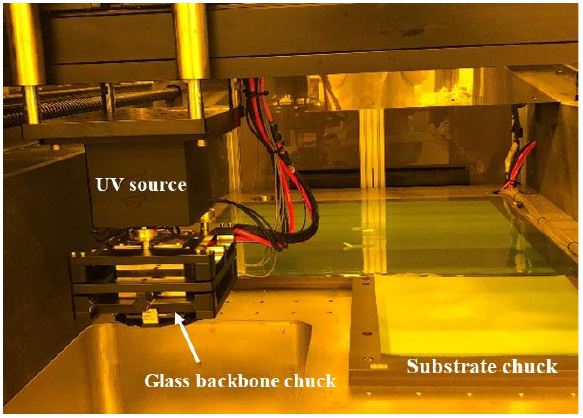
Figure 2. Step-and-repeat NIL system (ANT-520SUV developed by KIMM).